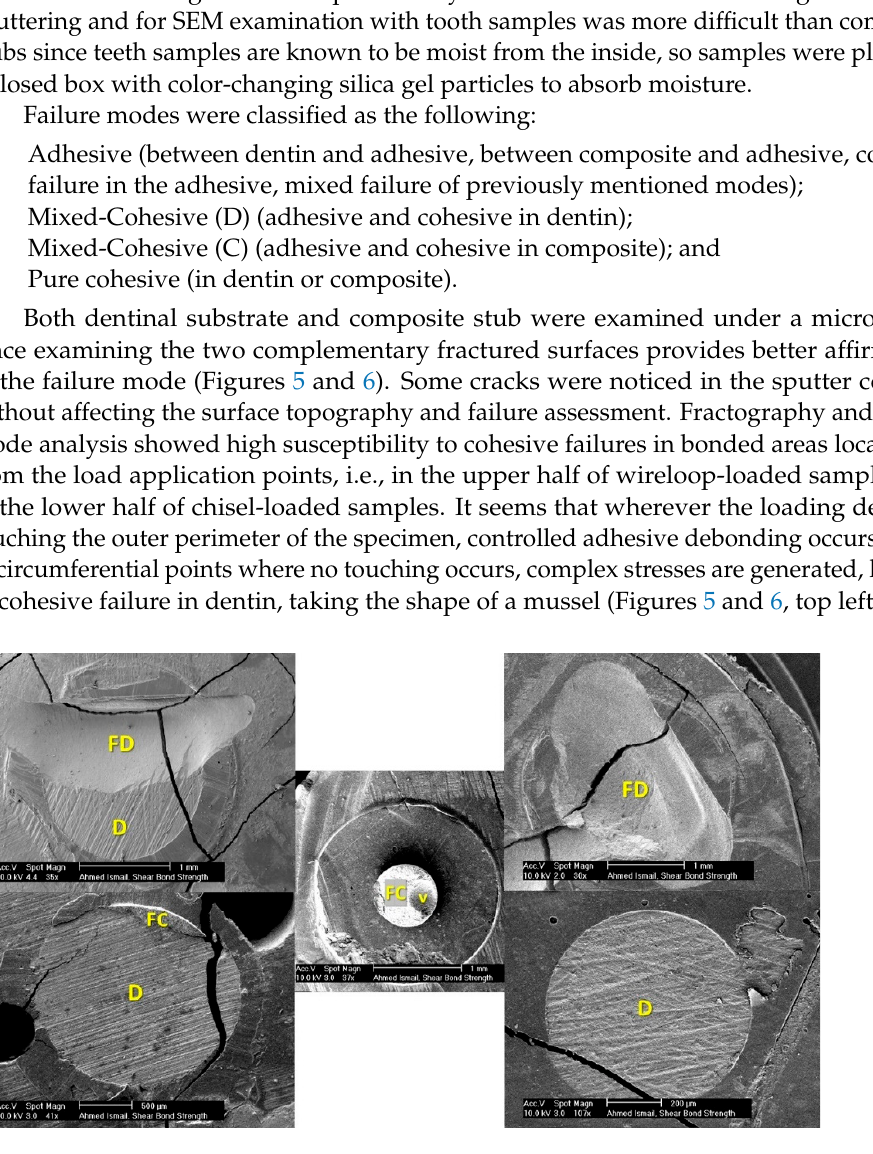
Figure 5. SEM images showing different failure modes in dentinal substrates. Top right: Cohesive (D); top left: Mixed-Cohesive (D); bottom right: Adhesive; bottom left: Mixed-Cohesive (C); center: Cohesive (C). D = dentin; V = void; FD = fractured dentin; FC = fractured